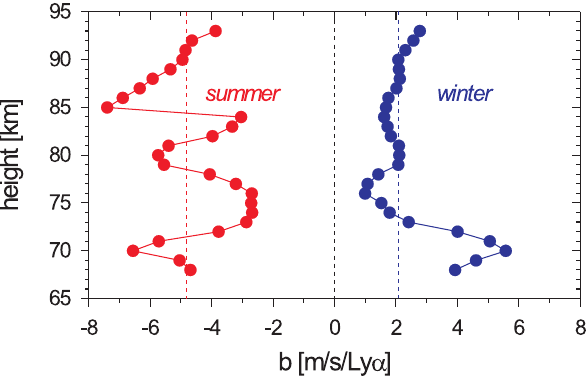
Fig. 6. Partial regression coefficient b (see Eq. 1) between the meso- spheric zonal wind at Juliusruh and the solar activity with a depen- dence on height for summer (red) and winter (blue). Red and blue dashed lines are the corresponding median b values derived from all